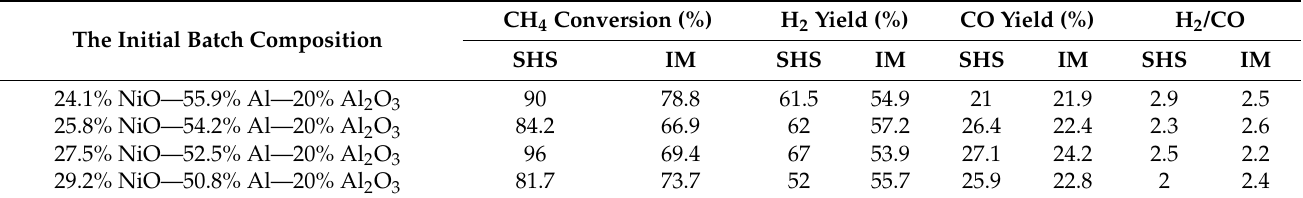
Table 2. Oxidative conversion of CH 4 on the NiO–Al- α -Al 2 O 3 catalysts prepared using the SHS and impregnation